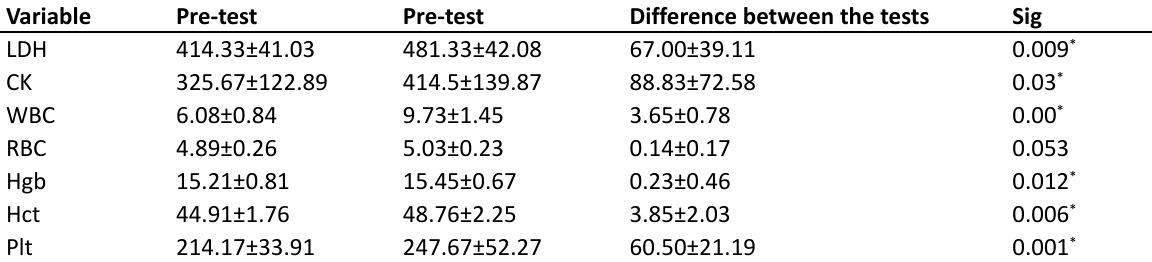
Table 3. Comparison of the pre-test and post-test in the control group